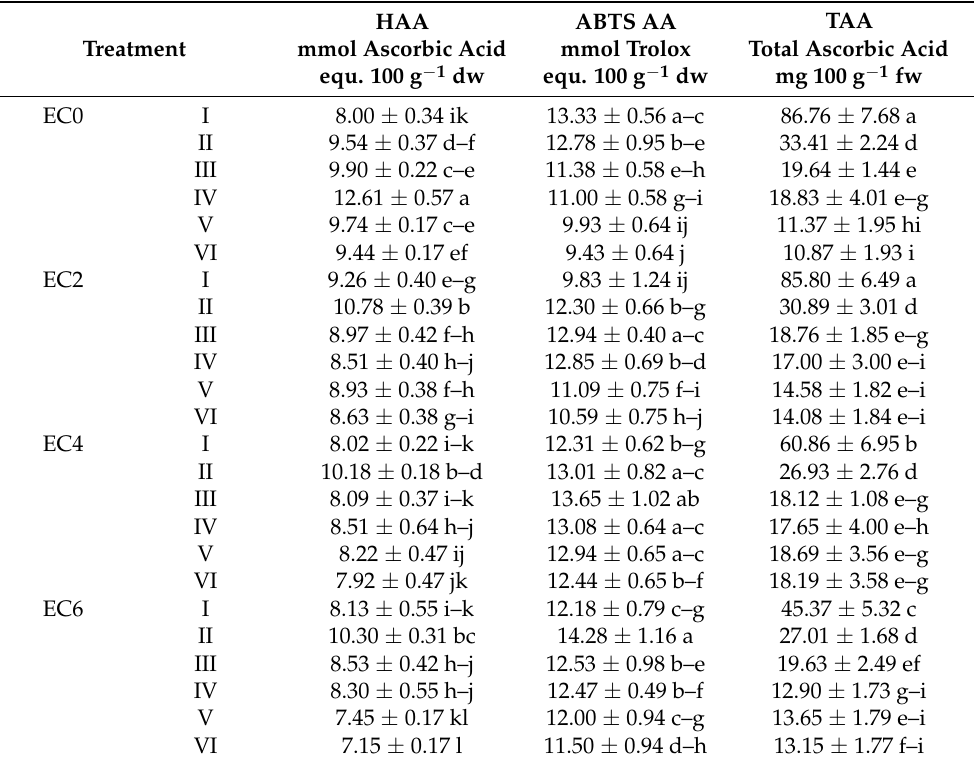
Table 3. Effect of salinity and biostimulant on hydrophylic antioxidant activity (HAA), ABTS an- tioxidant activity, and total ascorbic acid (TAA) content in Diplotaxis tenuifolia leaves, regardless of biostimulant